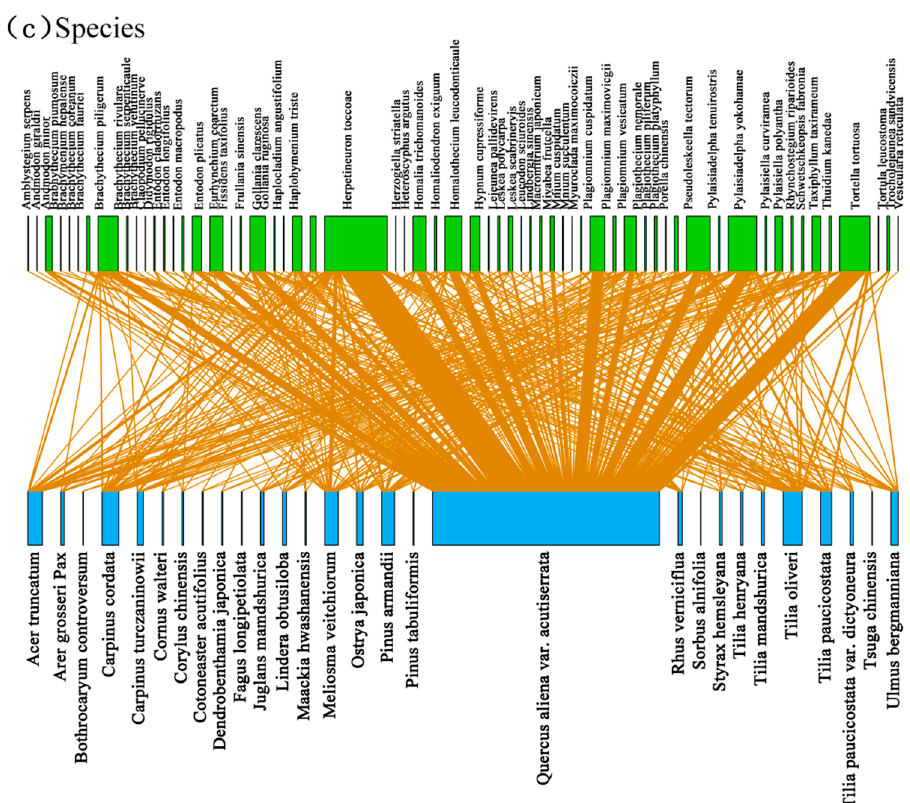
Figure 3. Bipartite display of the plant and bryophytes network. The entire network includes all the 28 woody plant species in 21 genera and 15 families (top) and the 61 bryophyte species (bottom). The thickness of lines and the size of rectangles represent the number of observed associations. ( a ) is at family level, ( b ) is at genus level and ( c ) is at species level.